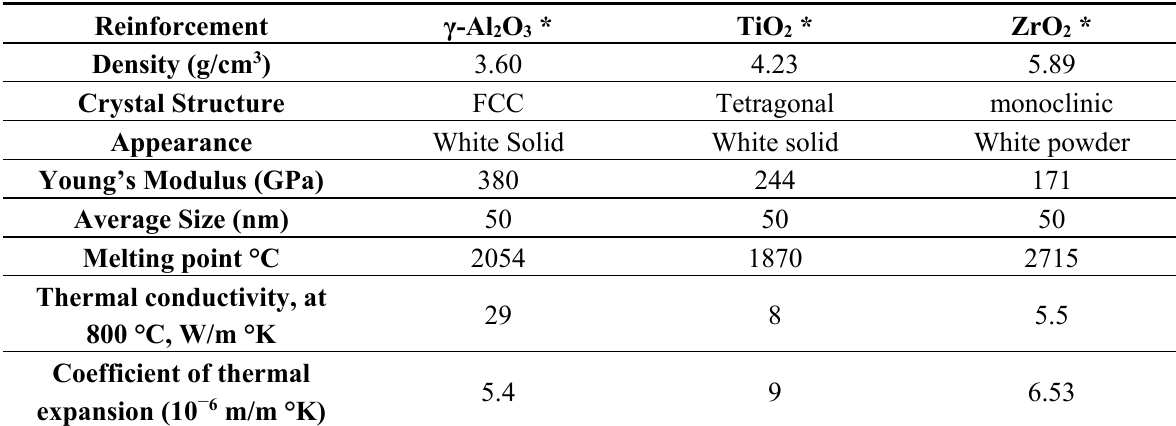
Table 4. Properties of Al 2 O 3 , TiO 2 and ZrO 2 Reinforcement Nanoparticles.